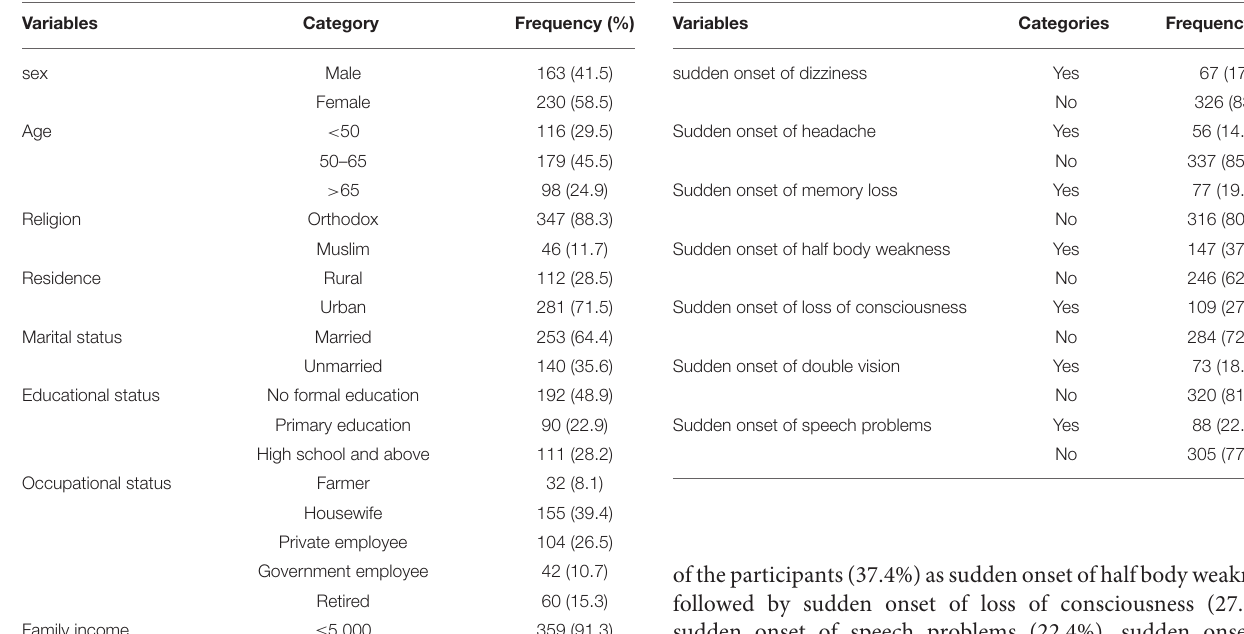
TABLE 1 | Socio-demography of participants attending in chronic illness follow-up Clinic of University of Gondar Comprehensive Specialized Hospital, Northwest, Ethiopia, 2021 ( n = 393).